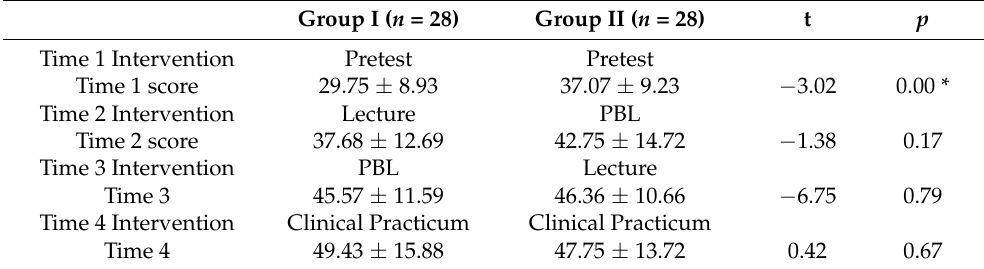
Table 2. The mean scores across four time schedules between Group I and Group II’s interventions.